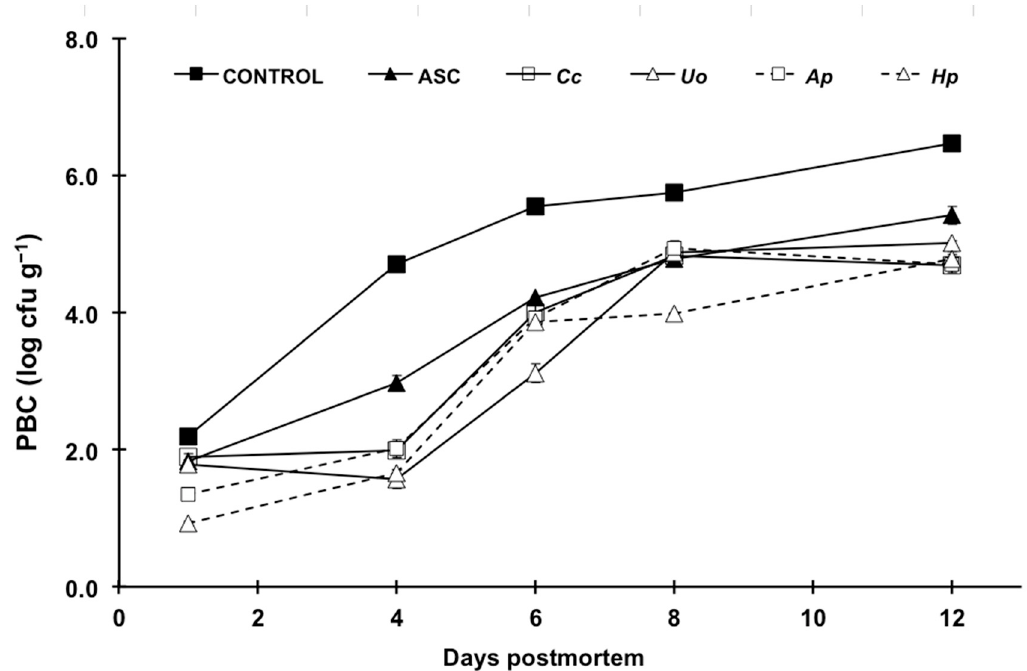
Figure 1. Changes in psychrophilic bacterial counts (PBC) in rainbow trout fillets treated with distilled water (CONTROL); ascorbic acid (ASC) and aqueous extracts of Crassiphycus corneus ( Cc ), Ulva ohnoi ( Uo ), Arthrospira platensis ( Ap ) and Haematococcus pluvialis ( Hp ) during a 12-day cold storage (4 °C) period. Values are expressed as mean ± sd. CFU stands for colony-forming units.